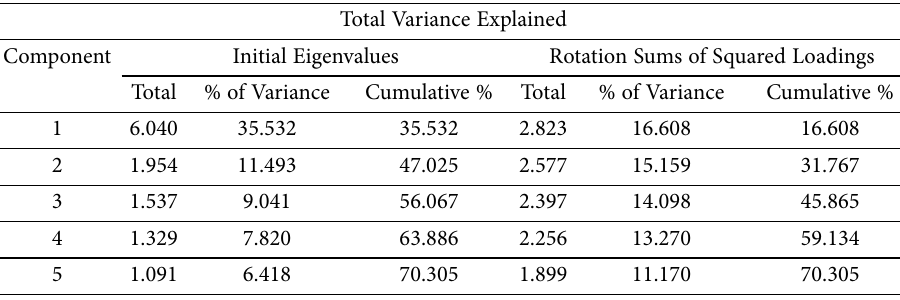
Total Variance Explained